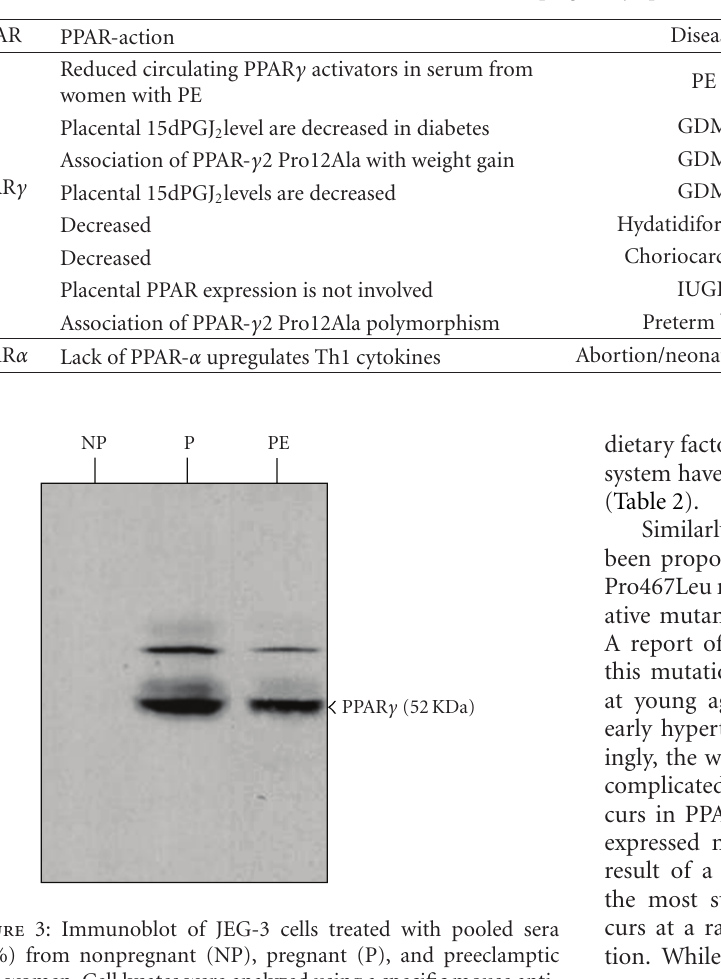
Table 5: PPAR in pregnancy-specific diseases.